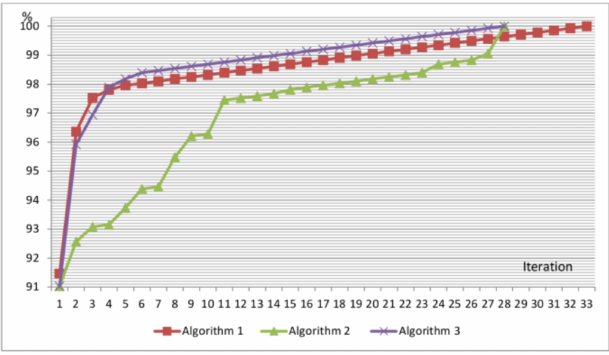
Figure 5. Comparison of the FC aggregation for all three algorithms.